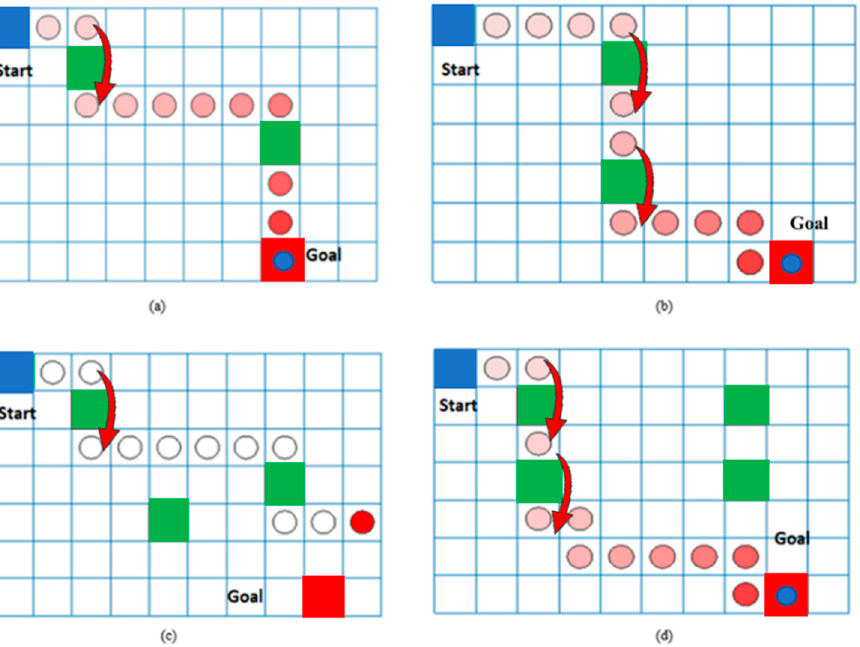
Figure 14. Path Traversed by the Agent ( a , b ) Two Obstacles ( c ) Three Obstacles ( d ) Four Obstacles using Double DQN Algorithm.